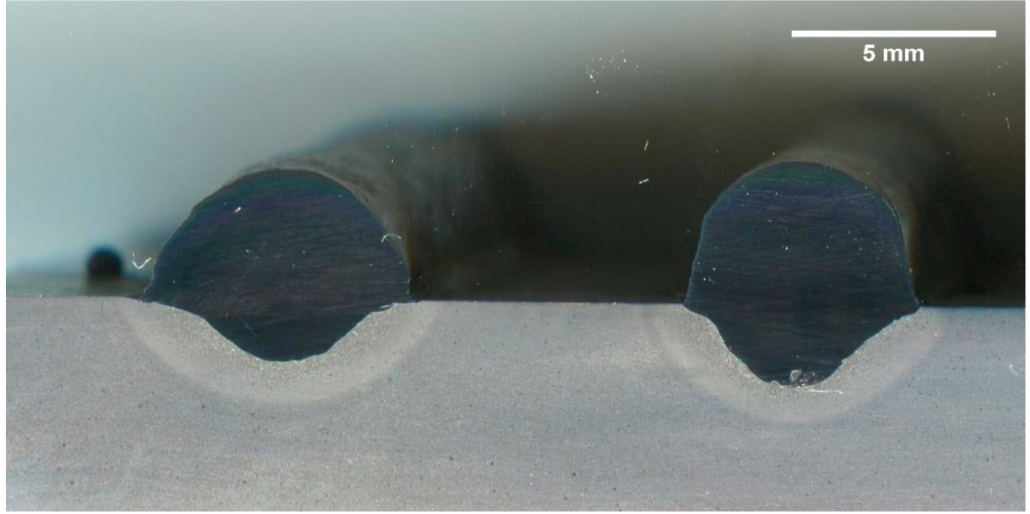
Figure 6. Bead-on-plate experiment using a binary ( left ) and ternary blend ( right